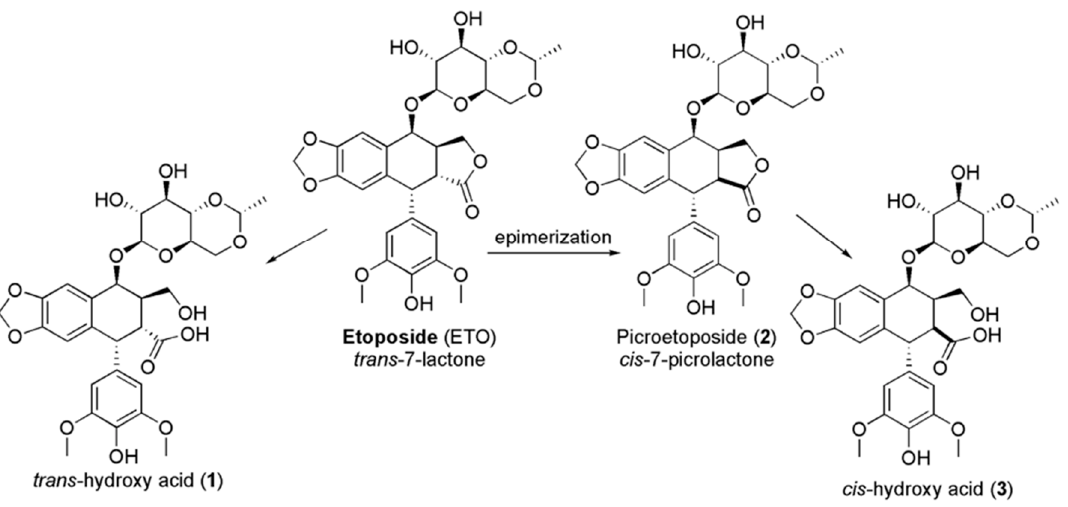
Figure 2. Deactivation of ETO by epimerization.